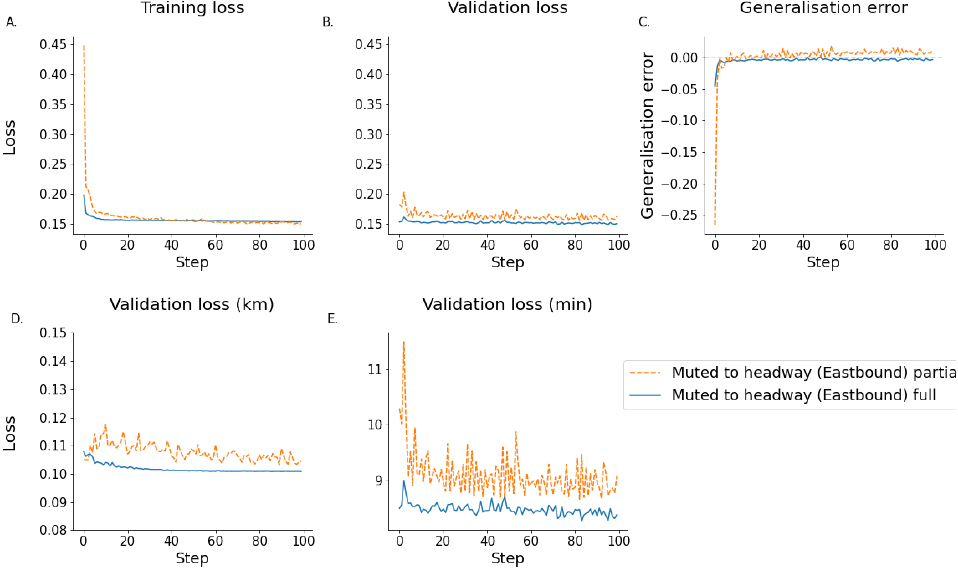
Figure 16. Comparison of the eastbound headway muted model trained on a partial as well as a full dataset. ( A ) shows the training loss. ( B ) shows the validation loss. ( C ) shows the generalisation error calculated by subtracting the training error from the testing error. ( D ) shows the estimated validation error in km. ( E ) shows the estimated validation loss in minutes. (Note that subfigure ( D ) has a truncated y axis for illustration